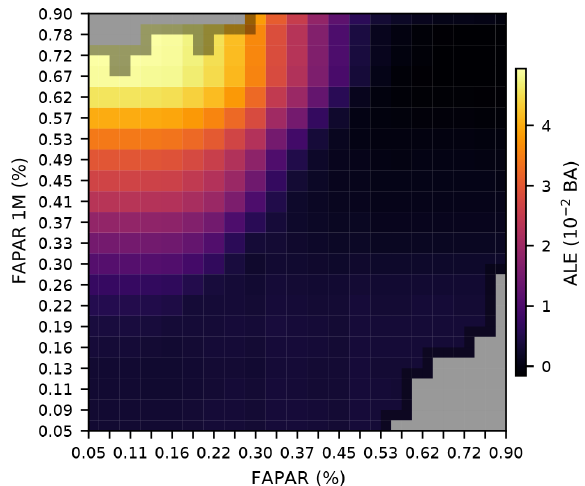
Figure 6. Second-order ALE plot showing the combined zeroth- order (mean), first-order, and second-order modelled effects of FA- PAR and FAPAR 1M on BA from the 15VEG_FAPAR model, tak- ing into account all other variables. Grey boxes indicate missing data. See Fig. S13 for the sample count matrix which demonstrates the correlation between the variables and thus shows that samples are unlikely to fall into the top-left or bottom-right bins. Evenly spaced quantiles were used in the construction and labelling of the plots. It can be seen that the combined effect of FAPAR and FAPAR 1M on BA is positive if FAPAR is low while FAPAR 1M is